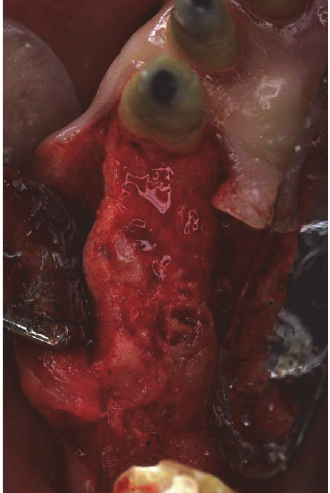
Figure 17: Implant insertion was completed in one surgical session underlocalanesthesia.Paracrestalfull-thicknessflapswereelevated.